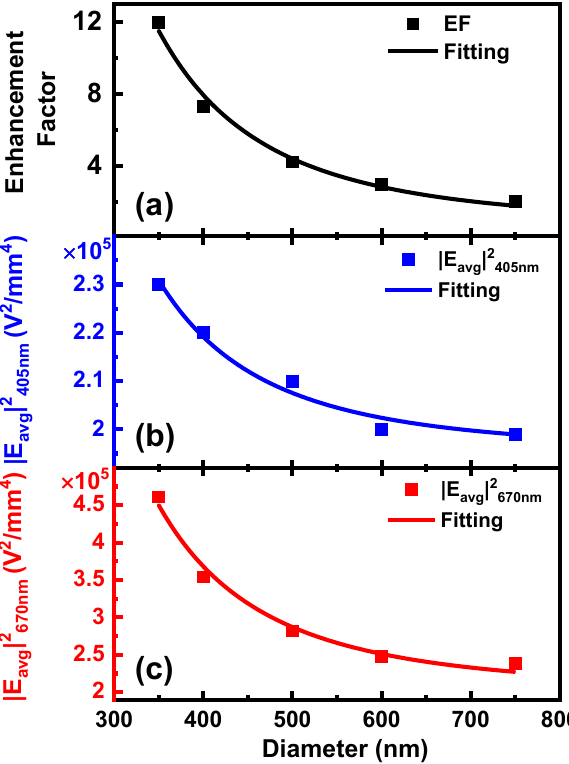
Figure 4: (a) Enhancement factor for each structure to enhance PL intensity of a 1-L MoS 2 , and the average E- fi eld intensity of each structure. The numerically calculated local fi eld enhancement of the Au metasurfaces per unit area under the excitation (b) and emission (c) wavelengths (405 and 677 nm),